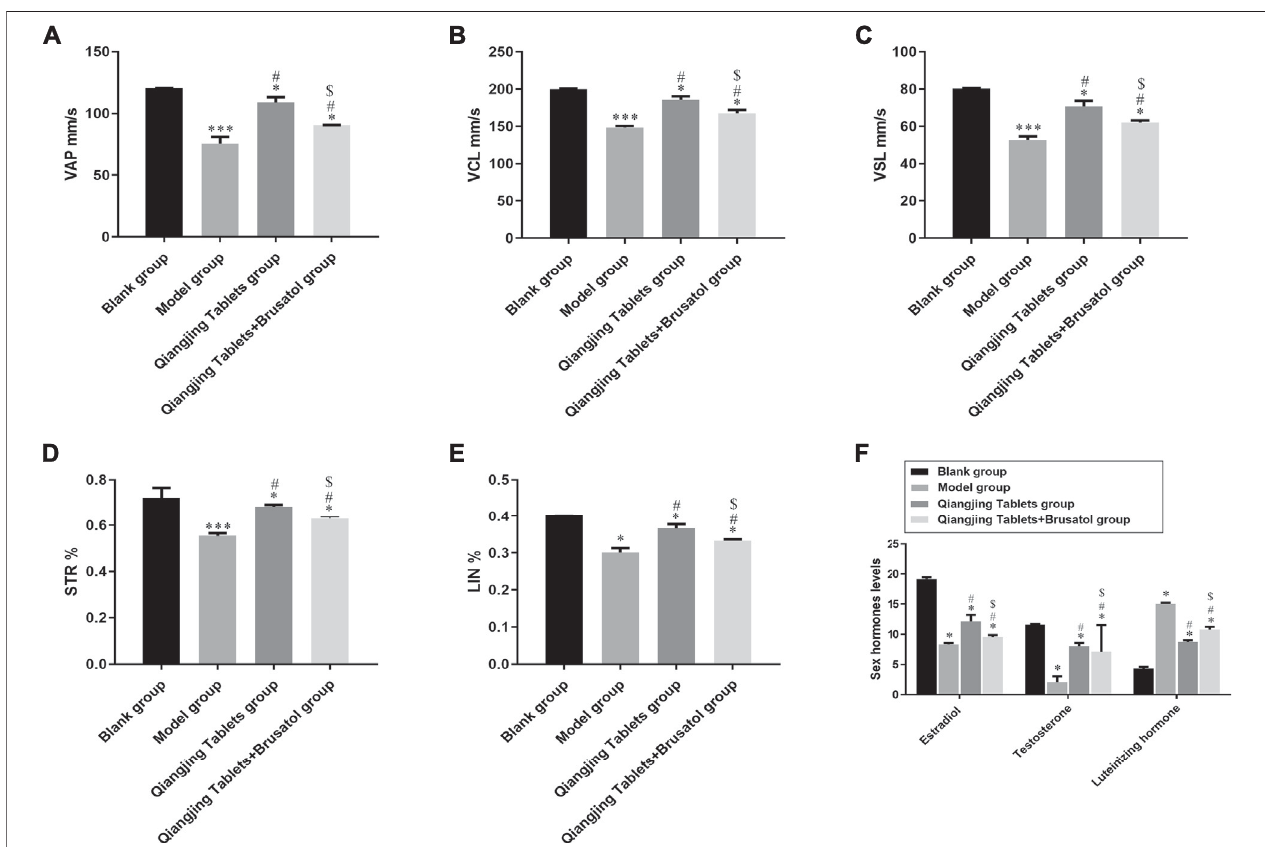
FIGURE 3 | Effect of Qiangjing Tablets on sperm parameters in AZS rats. (A) velocity average path (VAP, mm/s). (B) velocity curved line (VCL, mm/s). (C) velocity straightline(VSL,mm/s). (D) straightness(STR,%). (E) linearity(LIN,%). (F) Expressionlevelsofsexhormone(Estradiol,TestosteroneandLuteinizinghormone)inBlank